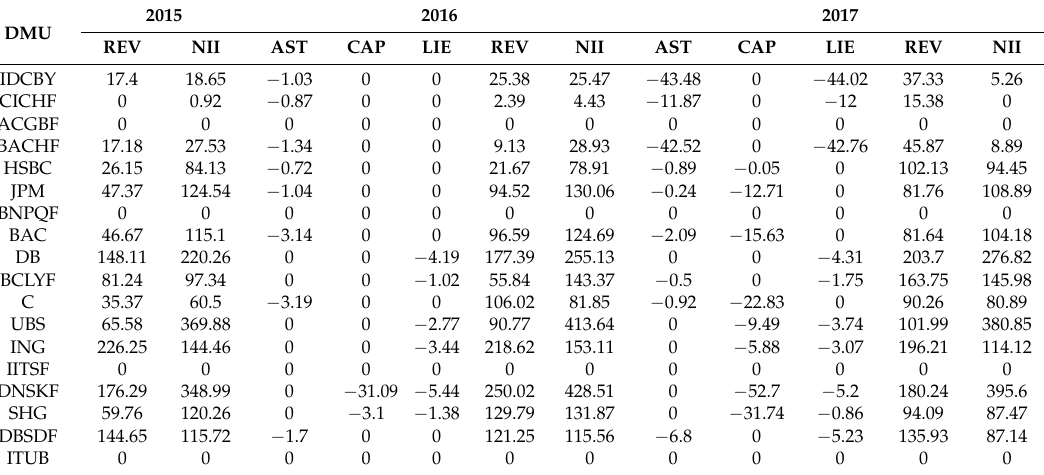
Table A4. Projections of large banks for 2016 −